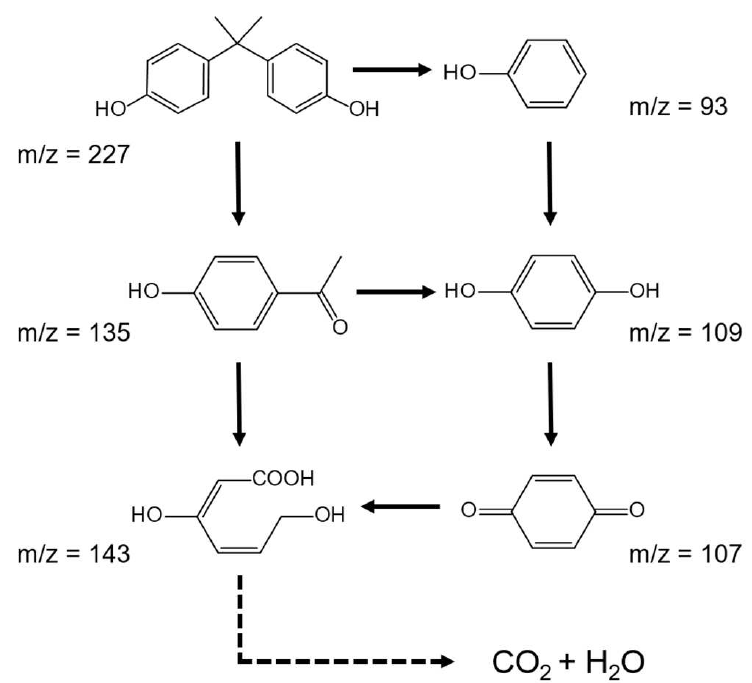
Figure 8. Proposed photocatalytic BPA degradation pathway.